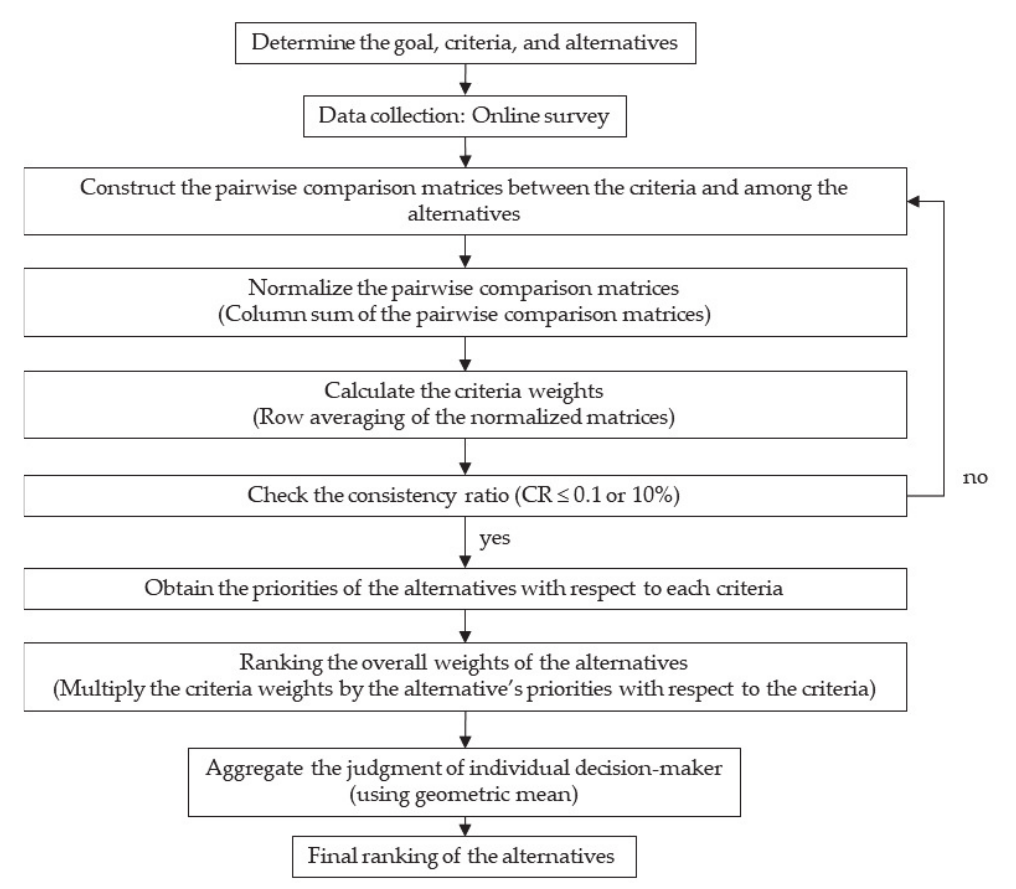
Figure 3. Summary of the AHP algorithm and computation steps.